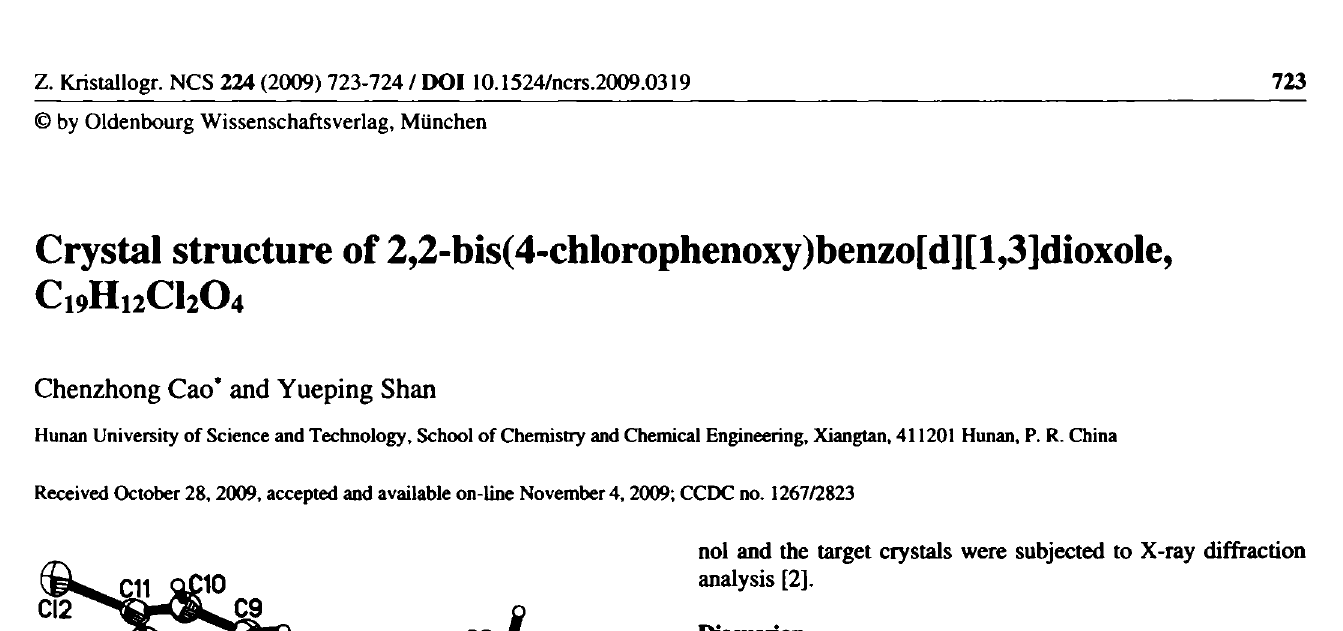
Table 1. Data collection and handling.